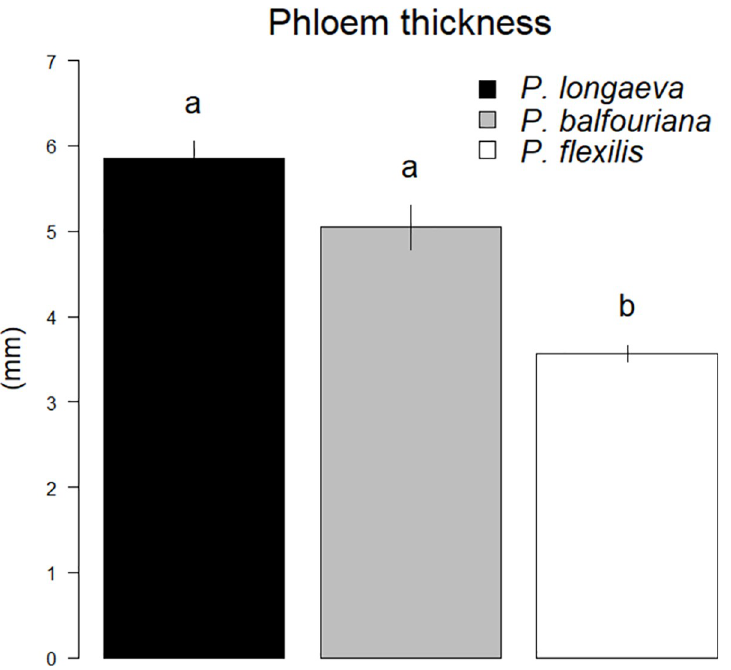
Fig 3. Phloem thickness ( ± standard error) in P . longaeva , P . balfouriana , and P . flexilis , averaged across all sites (see Fig 1; Table 1). Different letters (i.e., a,b) denote statistically significant differences among species means (p < 0.05). See Table 2 for statistics.